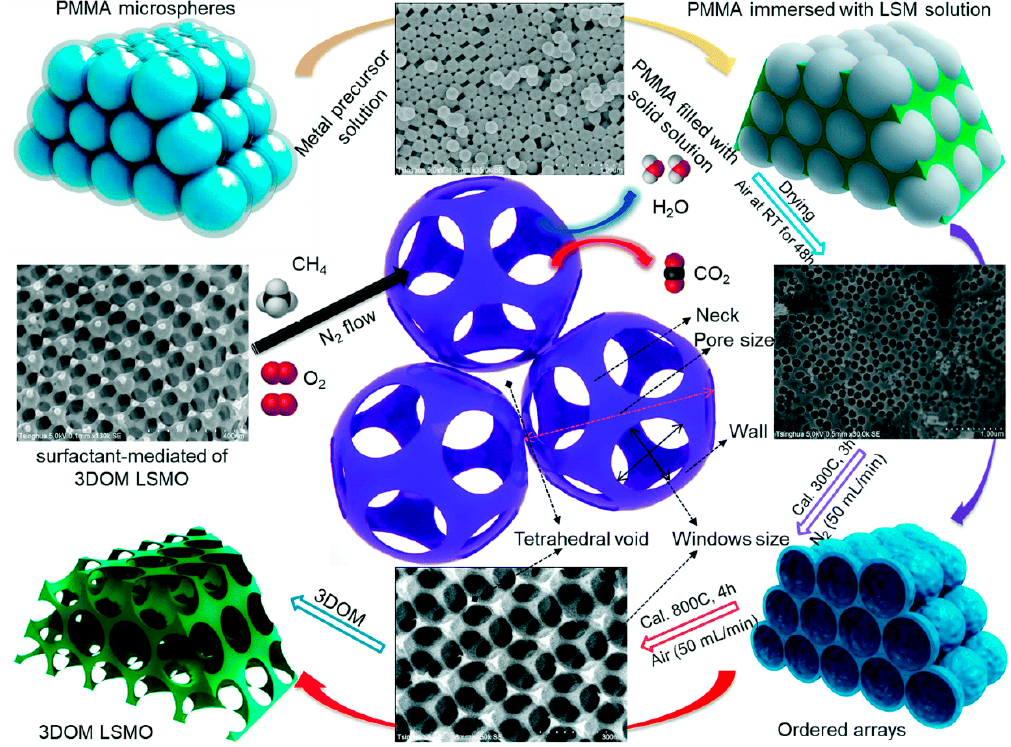
Figure 2. Preparation of rhombohedrally crystallized 3DOM LSMO catalysts using the PMMA-templating method. Reprinted with permission from Ref. [35] . Copyright 2018, copyright Royal Society of Chemistry.